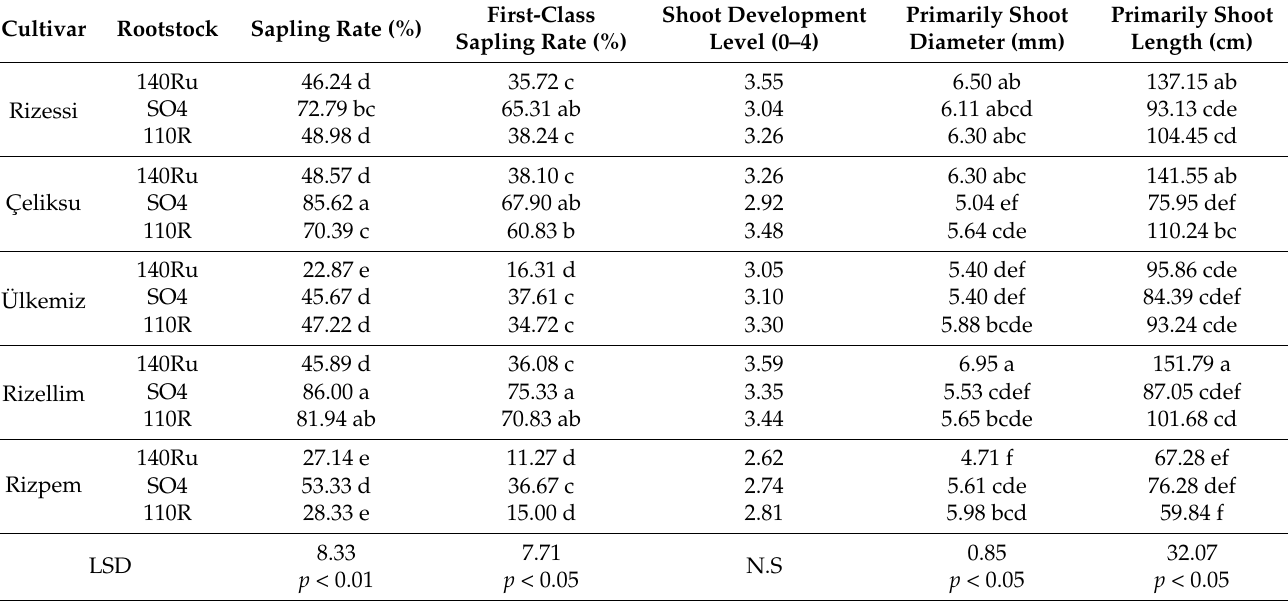
Table 2. Sapling rate and quality criterias of foxy grape varieties ( V. labrusca L.) grafted on different rootstocks-I.